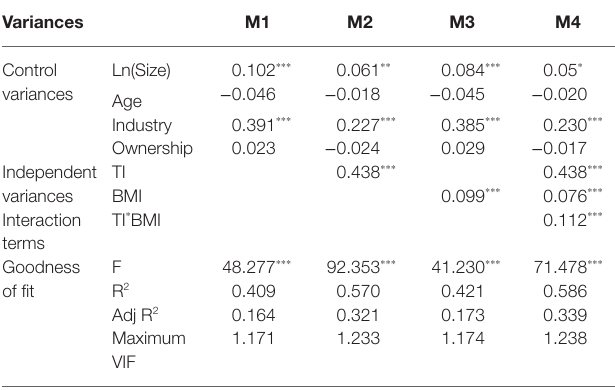
TABLE 3 | Hierarchical regression analysis results of firm growth. Variances